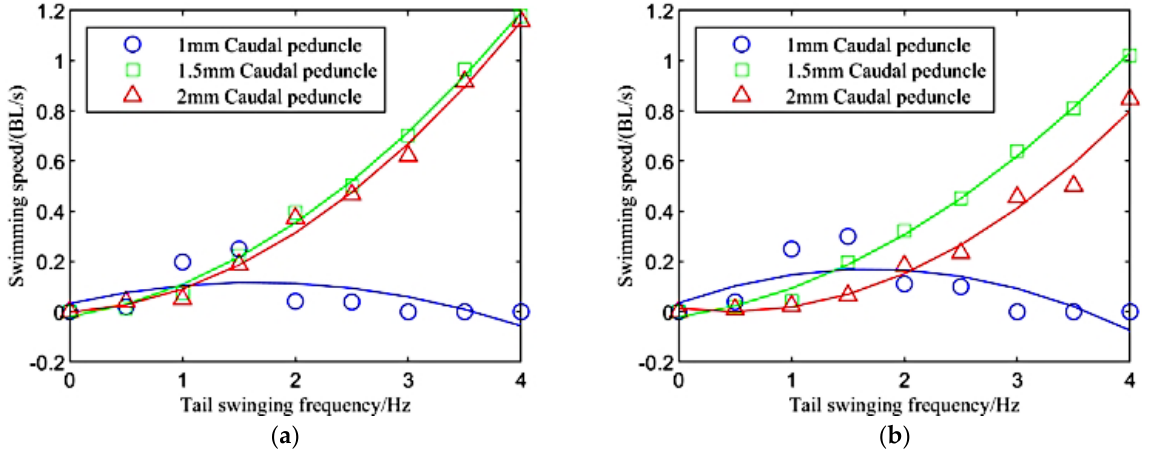
Figure 9. Swimming speeds of three types of motions with different stiffness of the caudal peduncle: ( a ) real fish motion; ( b ) cycloid motion.